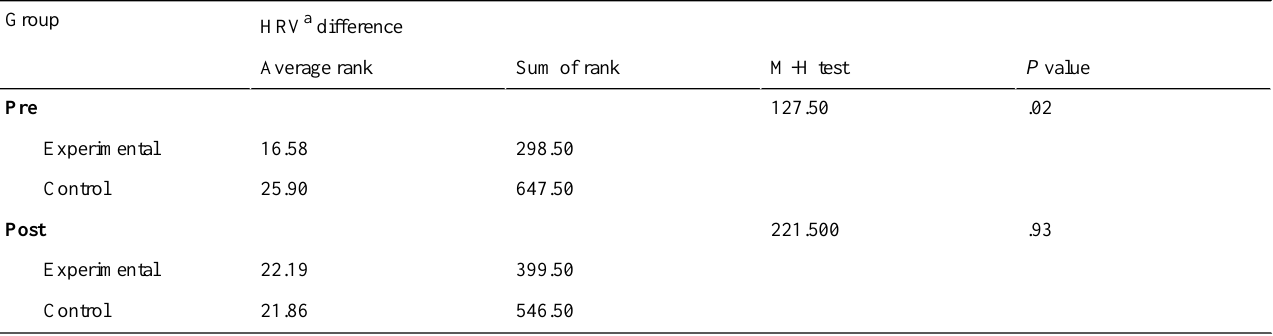
Table 3. Wilcoxon test for experimental and control group comparison.